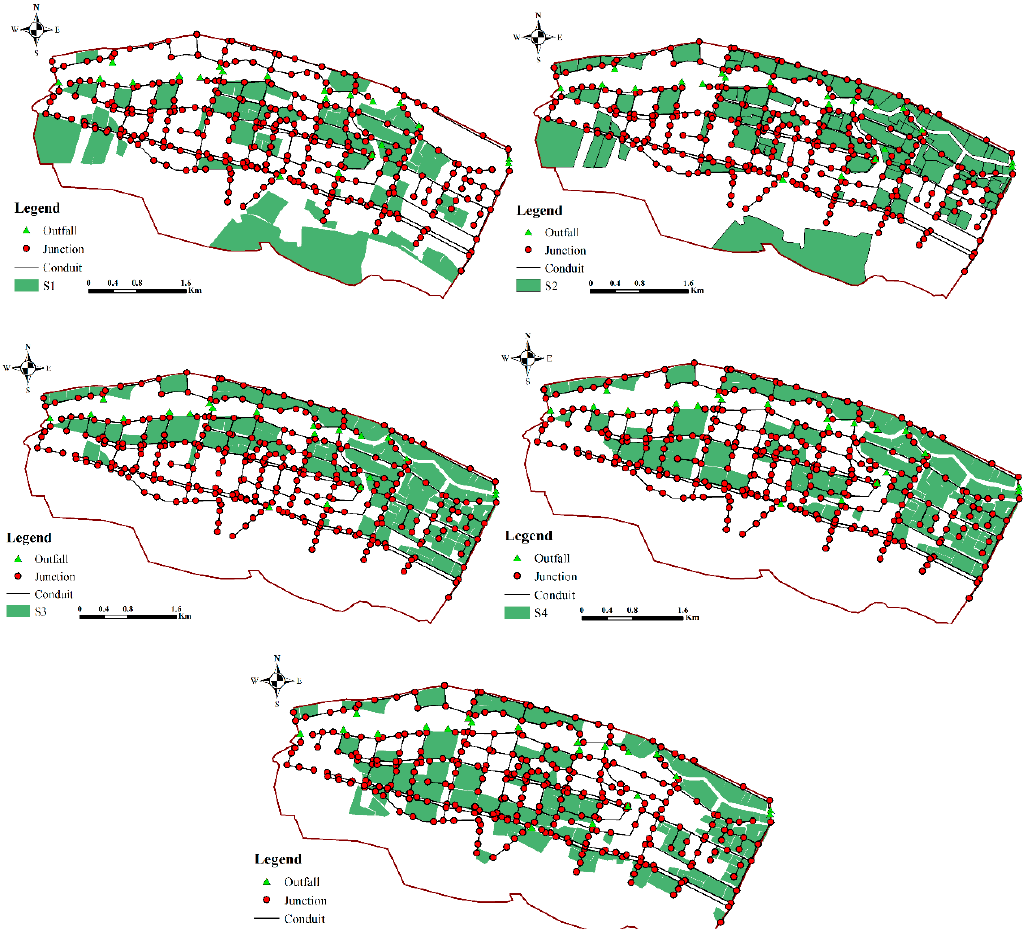
Figure 9. The spatial distributions of LID controls under five design scenarios.